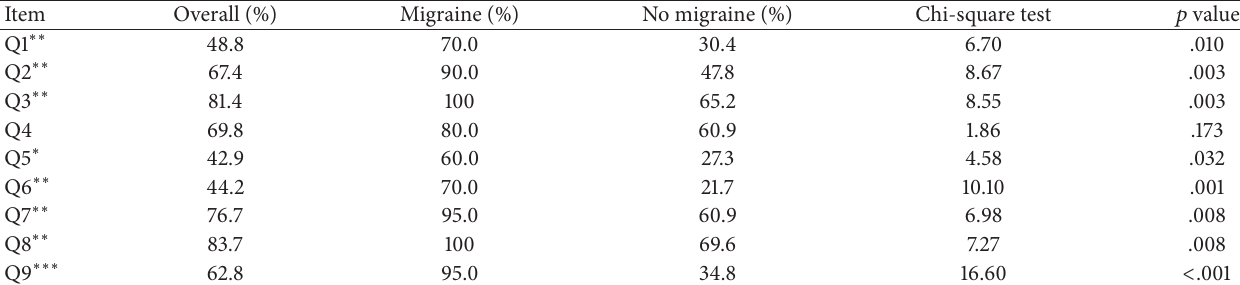
Table 2: Comparison of headache symptoms in migraine and no migraine groups on the Nine-Item